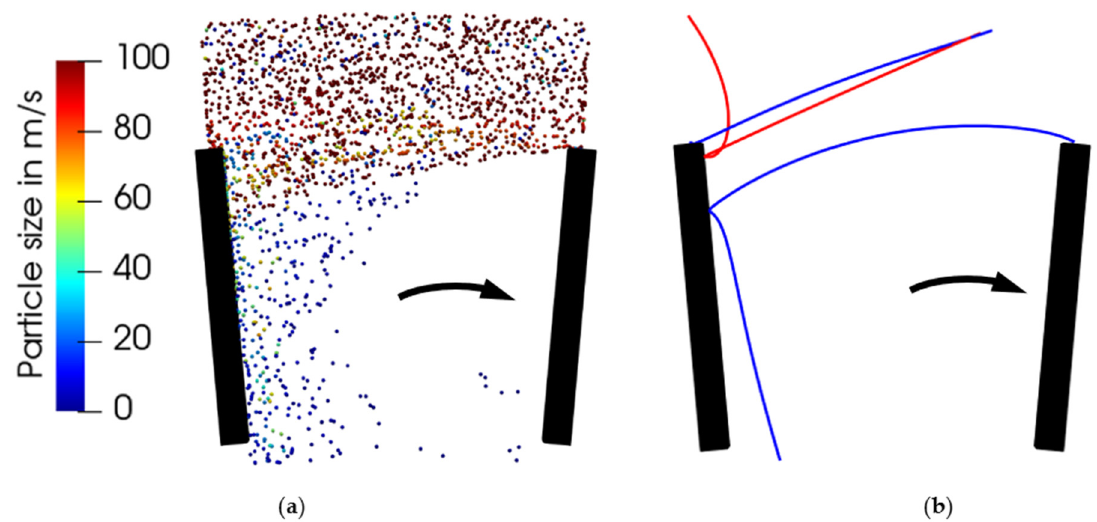
Figure 7. ( a ) Particle size distribution in front of and between classifier blades; ( b ) particle trajectories for a particle with a size of 10 μ m (blue) and 60 μ m (red).